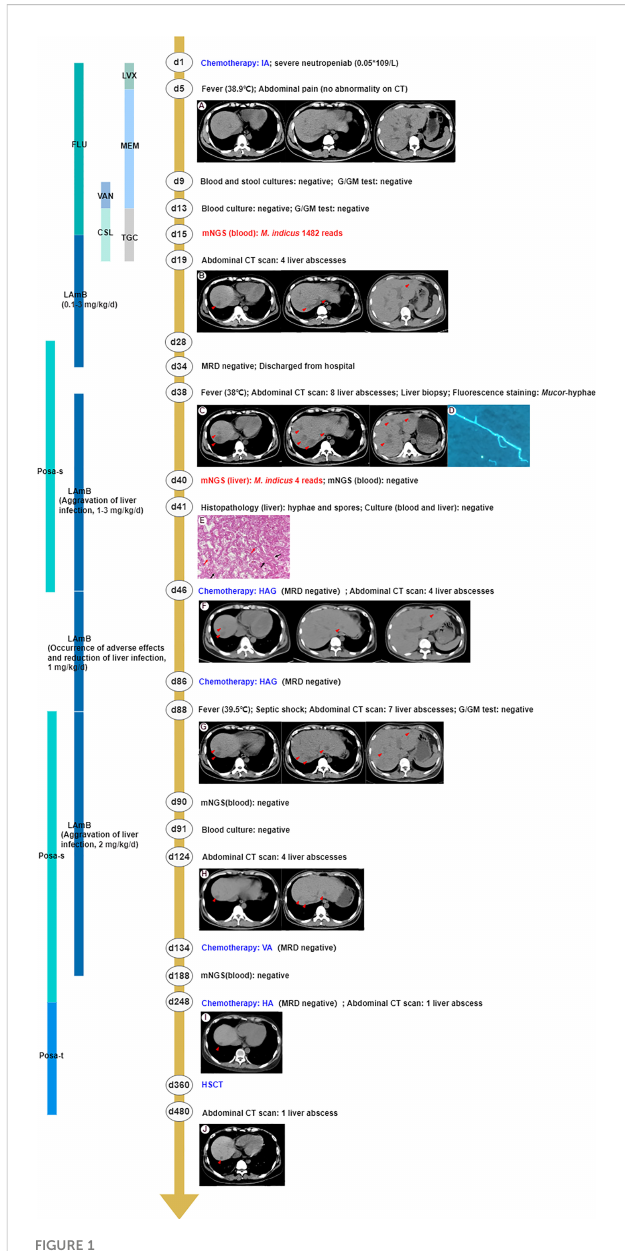
FIGURE 1 The clinical course of the patient (schematic). (A) The abdominal CT scan revealed no abnormalities. (B) The abdominal CT scan showed four low- attenuation liver lesions (marked in the red triangle). (C) Eight enlarged liver lesions were observed by abdominal CT. (D) Mucor-hyphae were found under fl uorescence microscopy using CFW staining. (E) The histopathology of the liver showed non-septate, irregular, branched fungal hyphae (black arrow) and spores (red arrow). (F) The number of liver abscesses was reduced to four, revealed by abdominal CT scan, implying that antifungal therapy had been effective. (G) Seven liver abscesses were revealed by the abdominal CT scan, suggesting aggravation of liver infection. (H) The abdominal CT scan showed four liver lesions, implying that antifungal therapy had been effective. (I, J) The number of liver abscesses was reduced to one and remained stable. Chemotherapy IA, idarubicin and cytarabine; CT, computed tomography; G test, (1,3)- b -D- glucan test; GM test, galactomannan antigen test; mNGS, metagenomics next-generation sequencing; MDR, measurable residual disease; HAG, homoharringtonine, cytarabine and G-CSF; VA, venetoclax and azacitidine; HA, homoharringtonine and cytarabine; HSCT, hematopoietic stem cell transplantation; LVX, levo fl oxacin; FLU, fl uconazole; MEM, meropenem; VAN, vancomycin; TGC, tigecycline; CSL, cefoperazone/sulbactam; LAmB, liposomal amphotericin B; Posa-s, posaconazole suspension; Posa-t, posaconazole